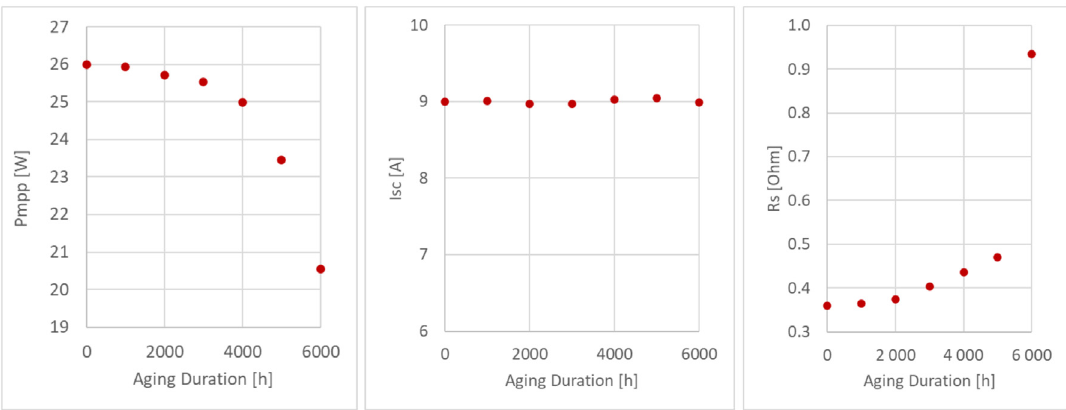
Fig. 6. Electrical parameter evalutation for an exemplary test module during 6000 h of Tropical 1